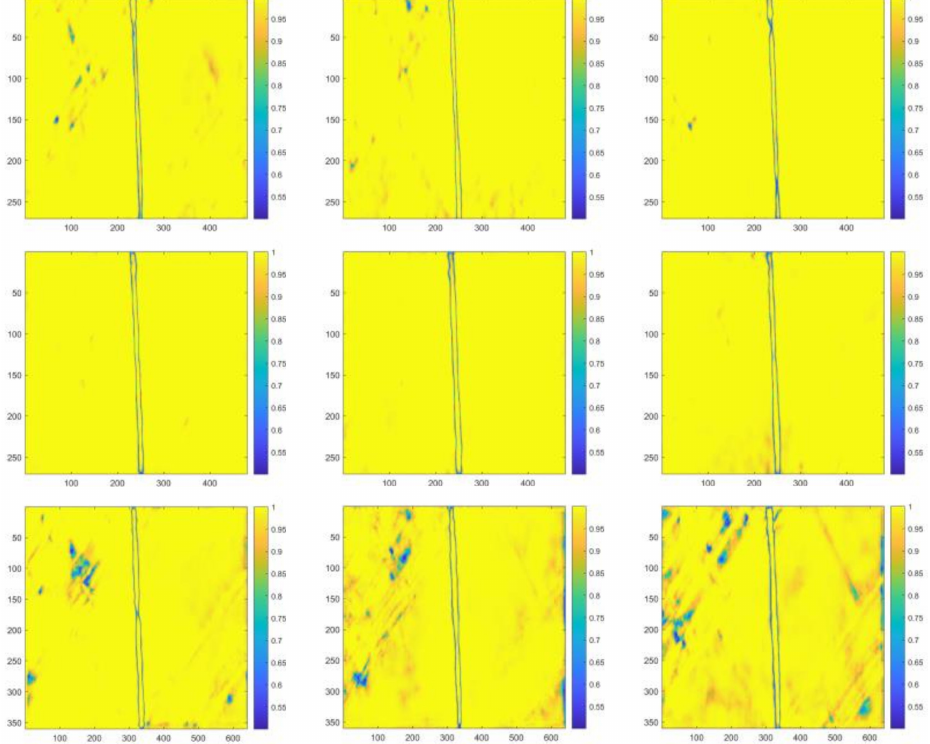
Figure 15. Visualized segmentation results in the heat map form of the same representative testing image with the C-T ratio of